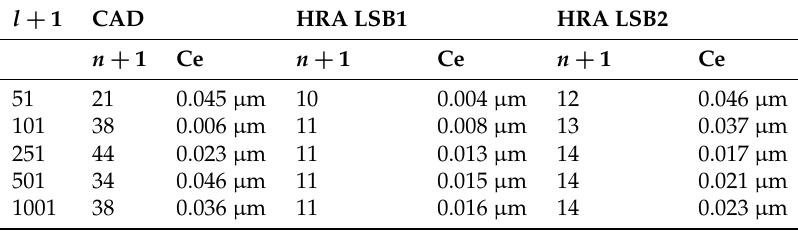
Table 4. Number of control points ( P i , i = 1, . . . , n + 1) and maximum fitting errors (Ce) for a